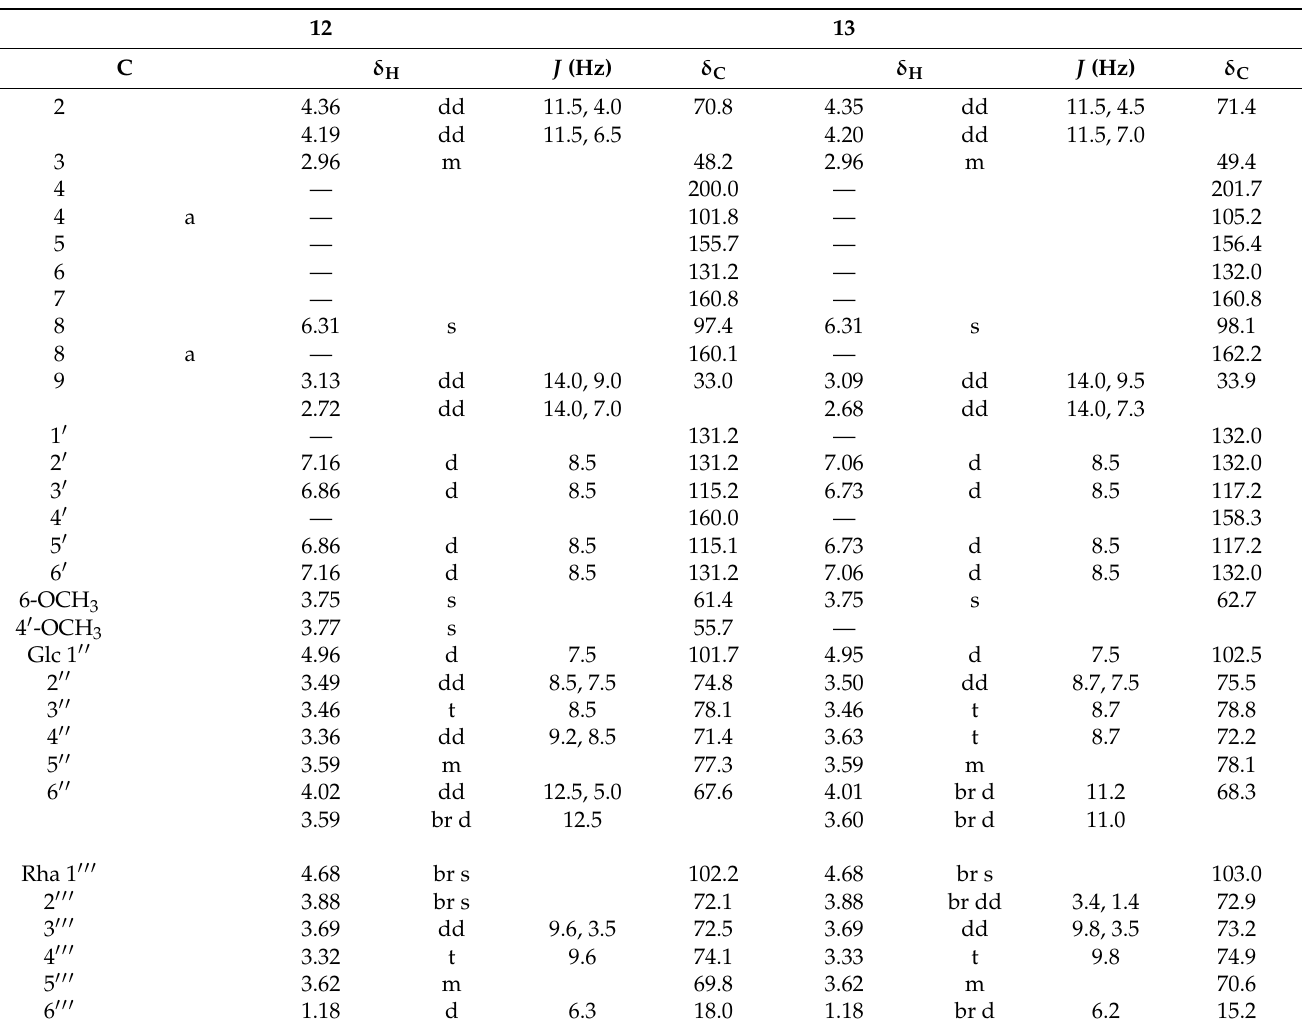
Table 3. 1 H and 13 C NMR (500 and 125 MHz, CD 3 OD) spectroscopic assignments of 12 and 13